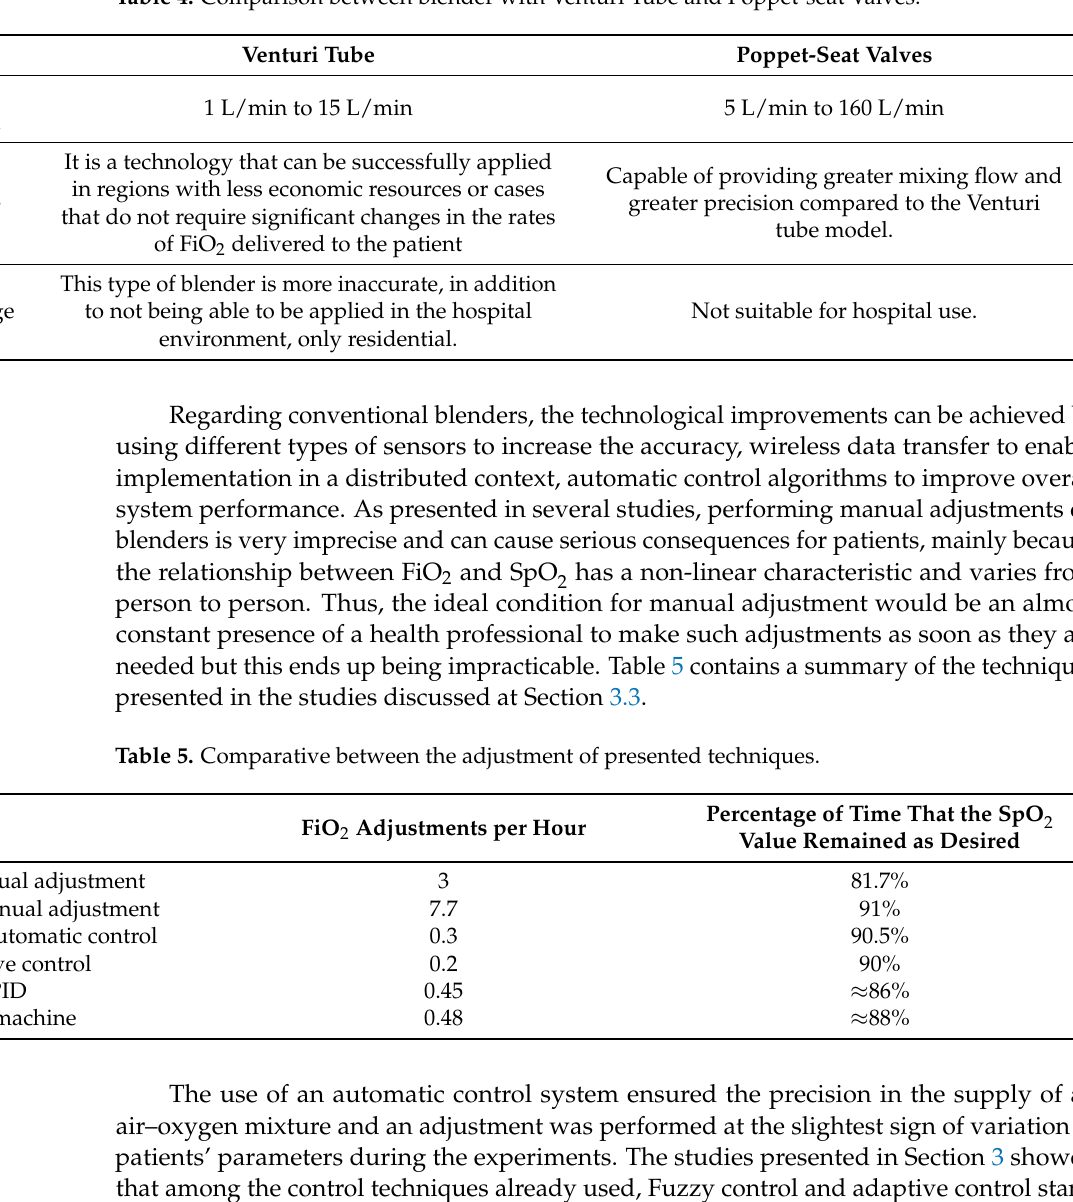
Table 4. Comparison between blender with Venturi Tube and Poppet-seat Valves.